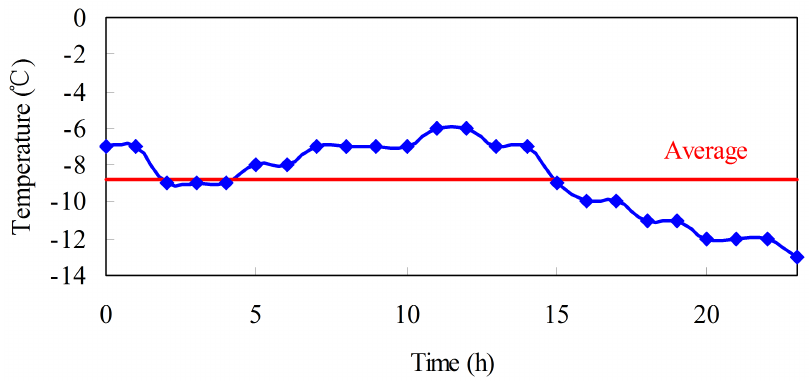
Figure 3. Temperature of Harbin (China) one day in